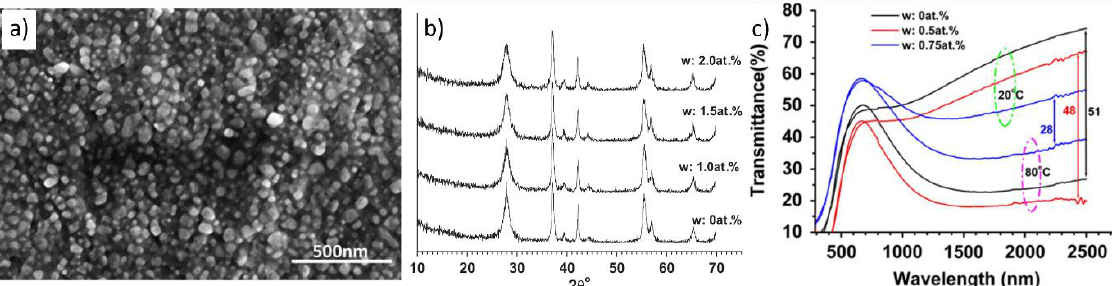
Figure 9. ( a ) SEM image and ( b ) XRD patterns of VO 2 (M) NPs; ( c ) Temperature-dependent transmittance spectra during phase transition of VO 2 (M) film. Reproduced with permission from [134] . Copyright 2011, Elsevier.